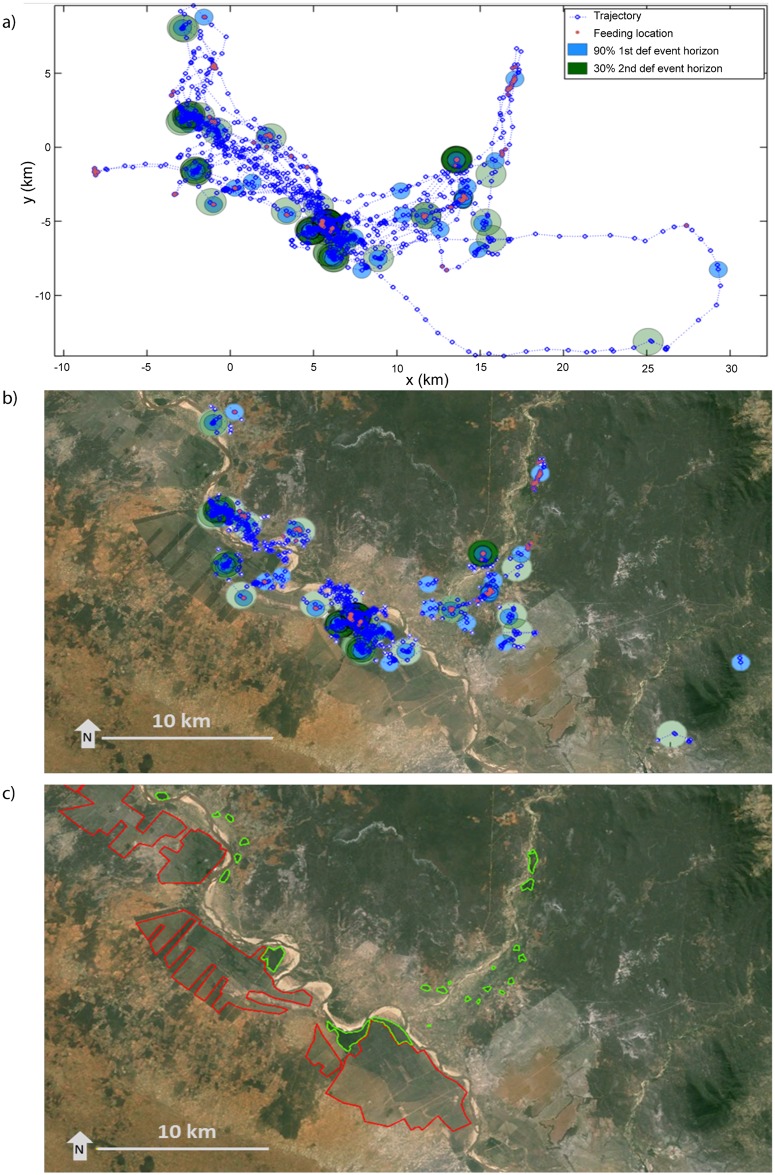
Seed shadow plots from all bats combined.The combined data of all 11 bats (45 nights of feeding) are plotted relative to the average position (a) and overlaid on a Google Earth map of the area (b) with major sisal plantation (red) and forest fragments (green) indicated (c). The rest of the habitat is composed of agricultural land, clearings, spiny forest or small groups of trees. All feeding locations are marked and the two defecation event horizons plotted corresponding to each feeding event. Light green and blue indicates a single defecation event (30% and 90% defecation probability respectively) while the darker colours indicate accumulations of several defaecation events. In (b) and (c) map data: Google, DigitalGlobe.